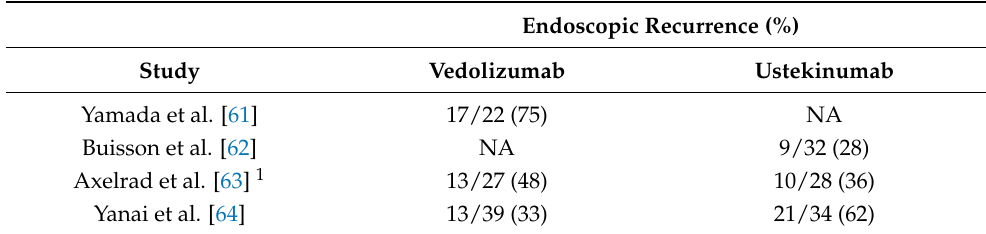
Table 2. Postoperative recurrence rates with ustekinumab and vedolizumab. Unless otherwise stated, recurrence rates were assessed between 6 and 12 months postoperatively.